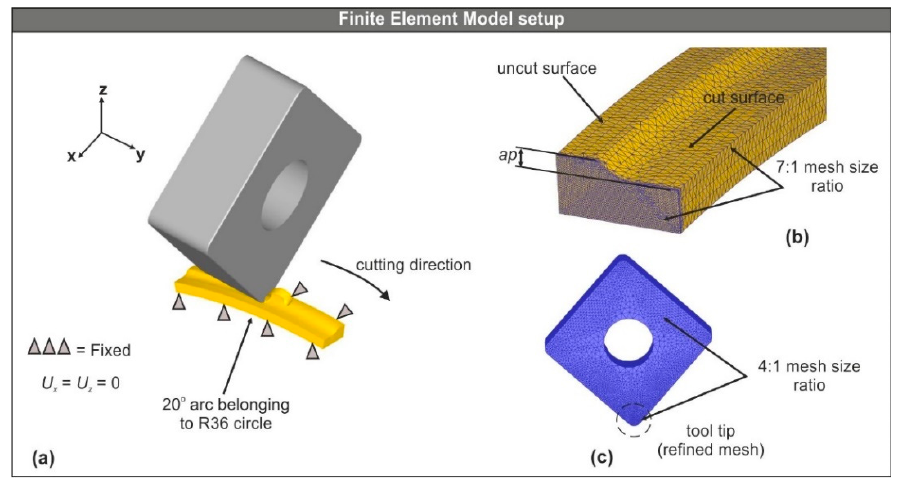
Figure 2. ( a ) The FE model setup, ( b ) the analysis domain, and ( c ) the meshed tool.